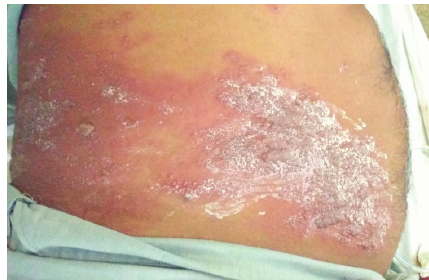
Figure 2: Vesicular eruption involving T8–T11 dermatomes.